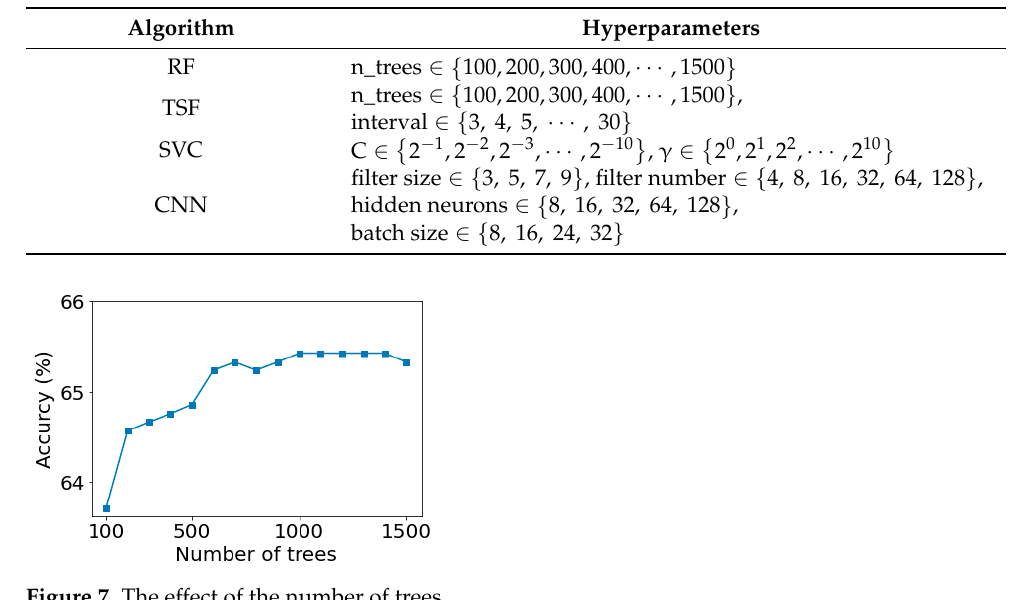
Figure 7. The effect of the number of trees.